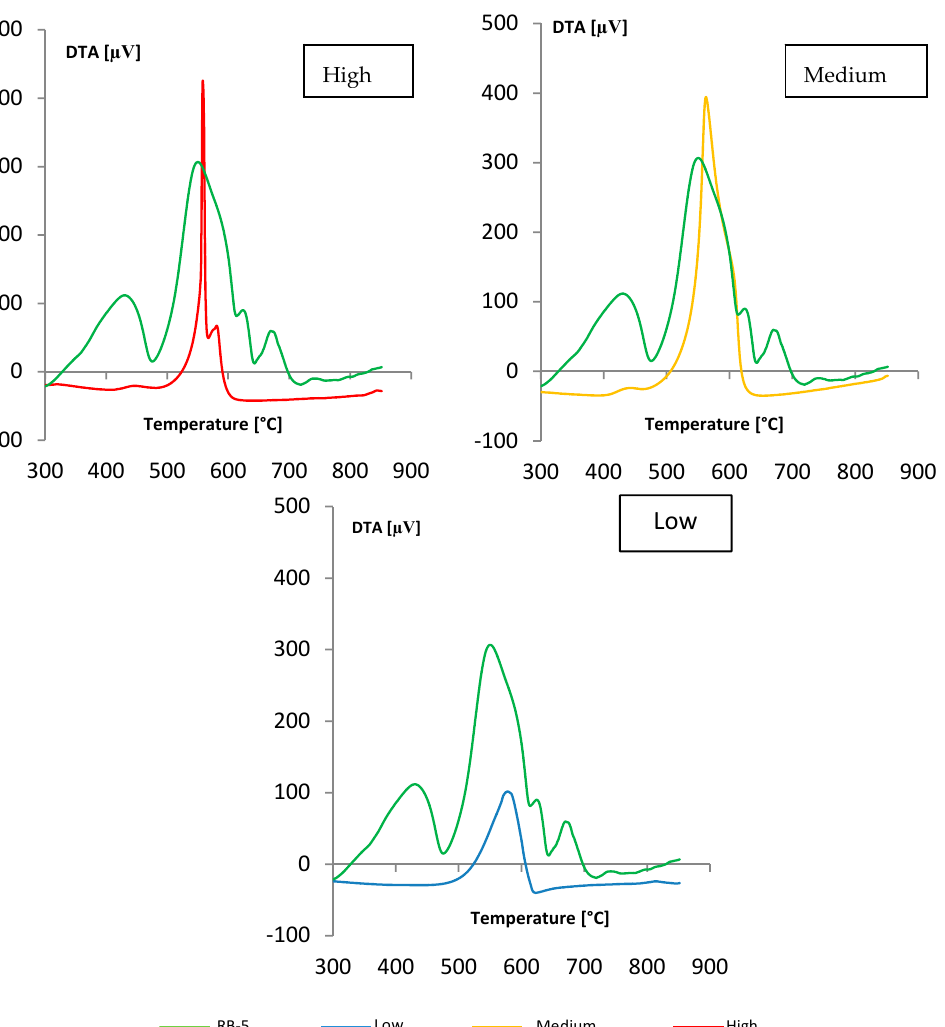
Figure 9. DTA curves of C1 column for different height of layers (high, medium, and low). DTA curves for the C1 column show two exothermal peaks at ca. 446 °C and 580 °C, very close to those of RB5 at 413 °C and 617 °C, respectively (Figure 9). The thermal analysis of the middle part of the MWCNT layer presented the same thermal behavior but the intensities of the exothermal peak of DTA curve were lower. The deeper layer presented exothermal peaks of DTA curve that were very low, almost invisible. This could be due to a smaller amount of dye adsorbed at this MWCNT layer. This observa- tion was the same for all of the analyzed columns. Figure 10 shows a zoom of the DTA peaks at ca. 446 °C, comparing the several heights for each column to highlight better the variation of exothermal peaks for each column.